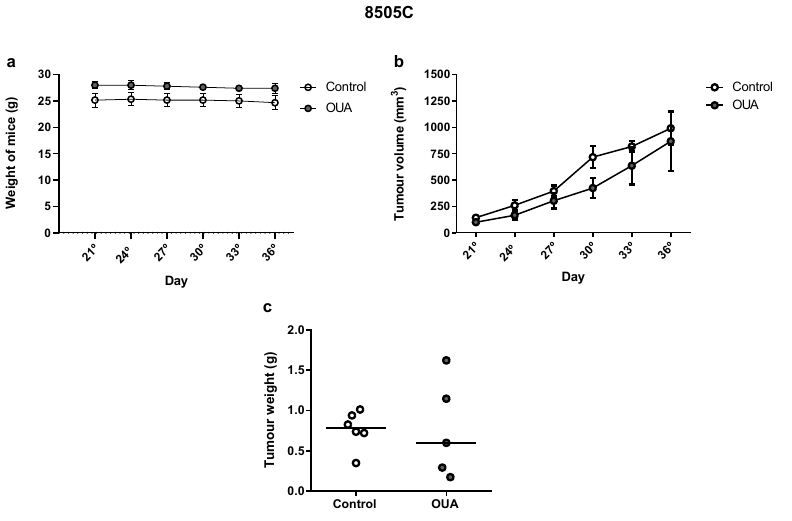
Figure 9. In vivoeffectofouabain. Balb/cnudemiceweresub-cutaneouslyinjectedwith ≈ 1078505Ccells. From the 21st day post-injection, mice were inoculated intra-peritoneally daily with vehicle or ouabain (10 − 7 M) for 15 days. ( a , b ) Graphs show mean weights ( a ) and tumor volumes ( b ) ± SEM measured once every three days. ( c ) Scatter plot represent the tumor weights after 15 days of treatment with reference lines showing the